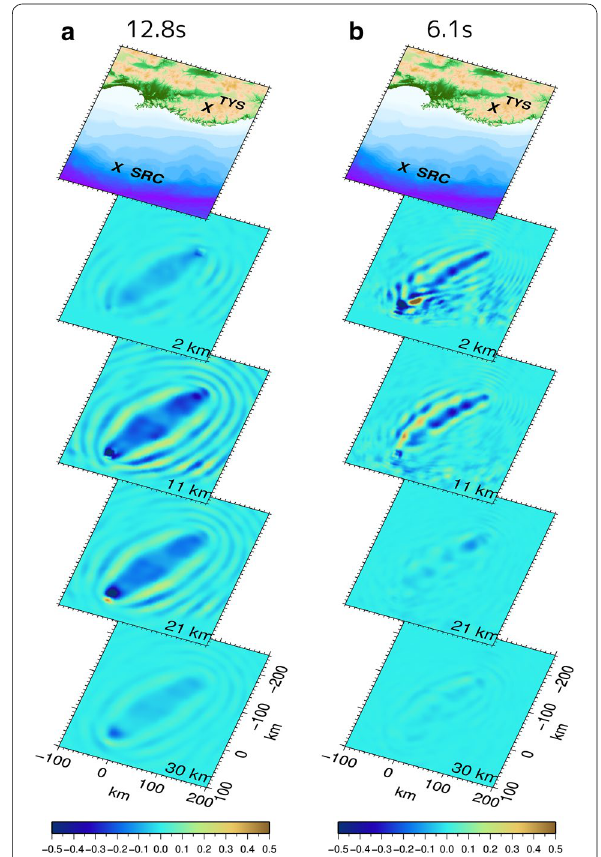
Fig. 5 Normalized, real part of rigidity kernels for period of a 12.8 s, and b 6.1 s, for the vertical component at station TYS (F-net). Crosses on the top map denote the locations of the FAMT solution (SRC) and the station (TYS), respectively. The horizontal slices of the three-dimensional kernels at depths of 2, 11, 21, and 30 km are displayed. The kernels are smoothed using a running average with a cell of 11.7 × 11.7 km horizontally and 6.3 km vertically, normalized with the maximum amplitude for each period, and clipped at a normalized amplitude of ±